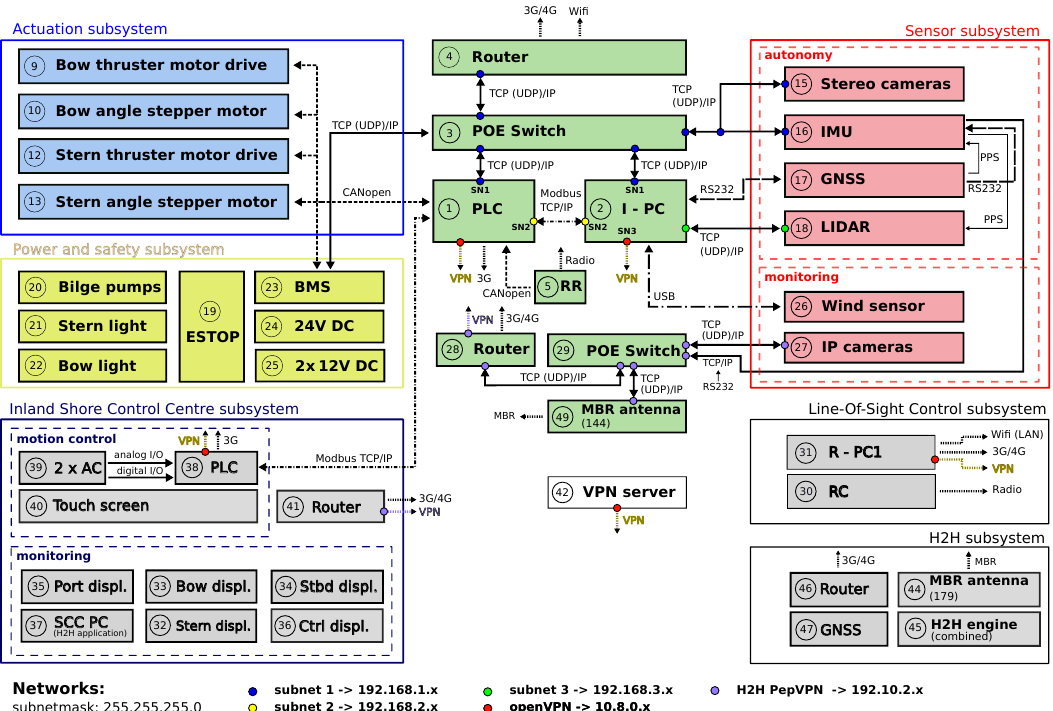
Figure 11. H2H-extended I-SCC and USV system design: main components and their communication links.